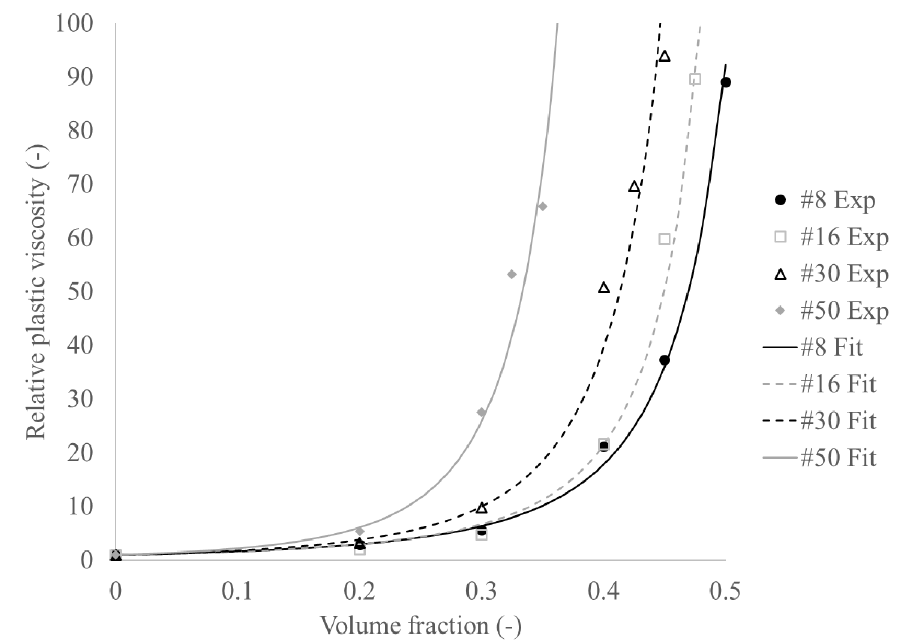
Figure 4. Increase in relative yield stress with increasing volume fraction.